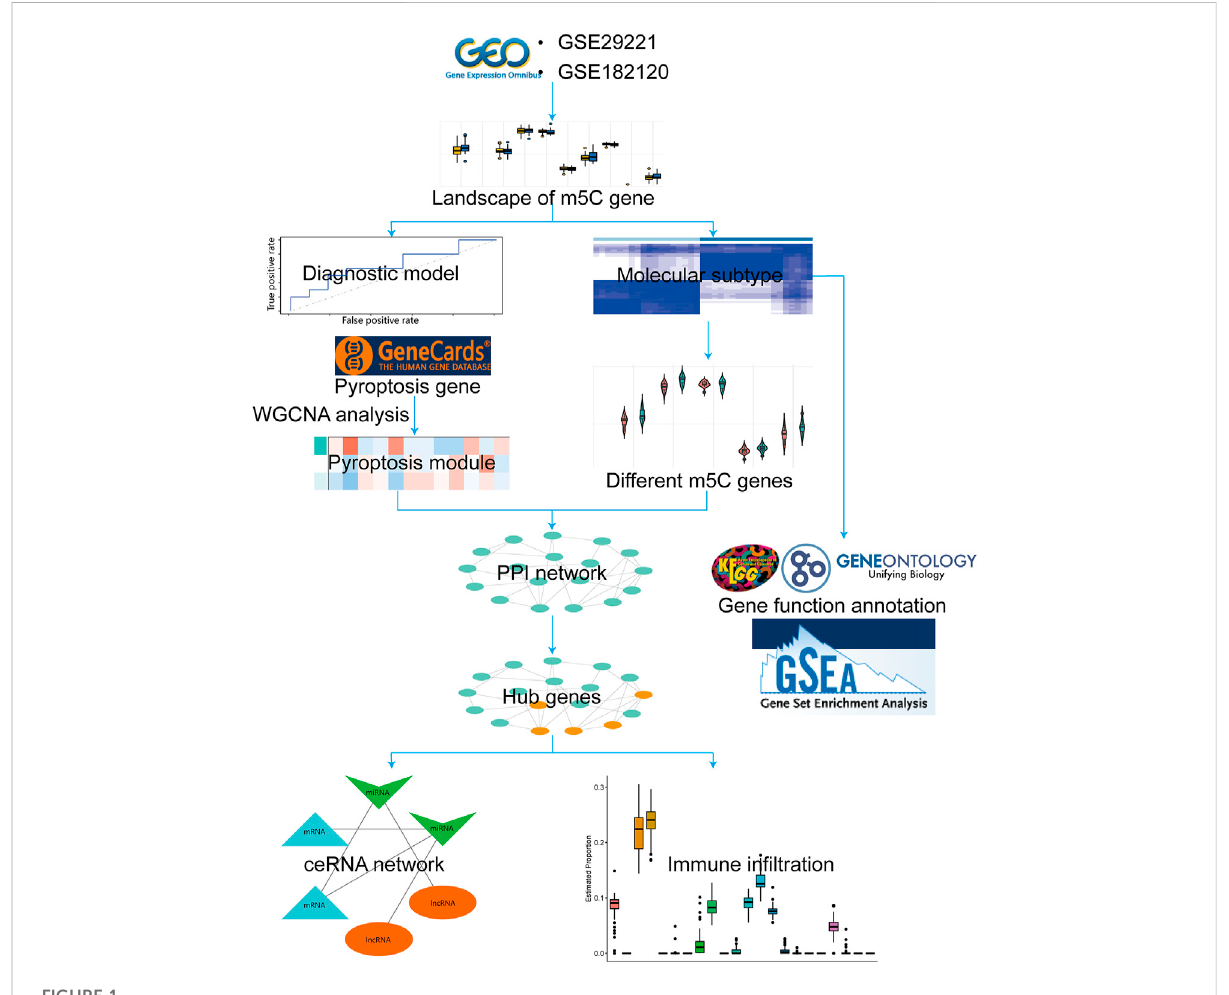
FIGURE 1 Work fl ow for the whole